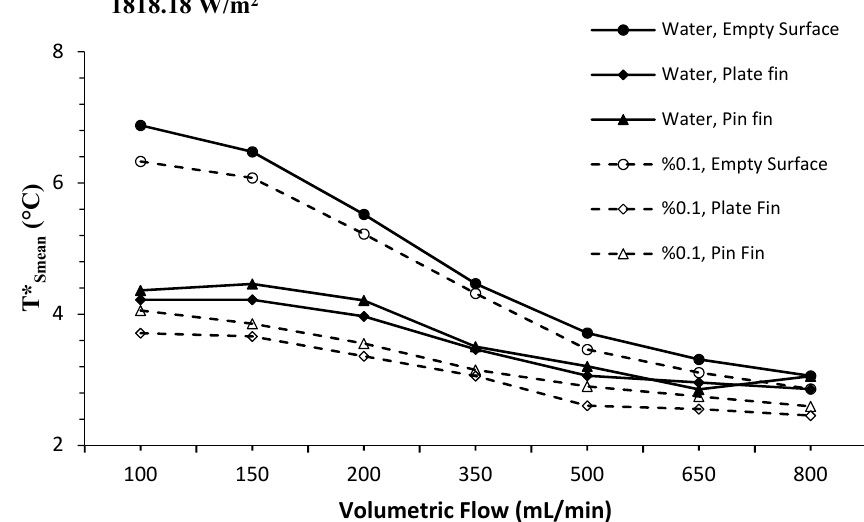
Figure 6. Variation of the mean surface temperatures with volumetric flow rate. The variation of the mean convective heat transfer coefficient according to different volumetric flow rates at 1818.18 W/m 2 for all surfaces where both fluids were used is given in Figure 7. The mean convective heat transfer coefficient increased for all the surfaces with increasing volumetric flow rate. In the case of using the nanofluid, it was clearly seen that the plate fin heat sink increased the heat transfer more than the empty surface and pin thin heat sink due to the intense solid-liquid interaction.